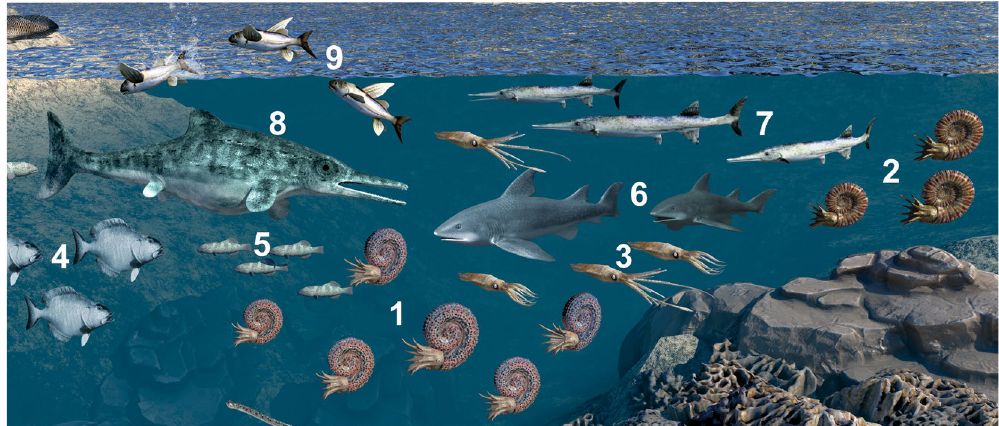
Figure 7. Trophic interactions of the ammonoid members from the Carnian Polzberg palaeobiota. 1 Austrotrachyceras minor , 2 Paratrachyceras haberfellneri , 3 Phragmoteuthis bisinuata , 4 Polzbergia brochatus